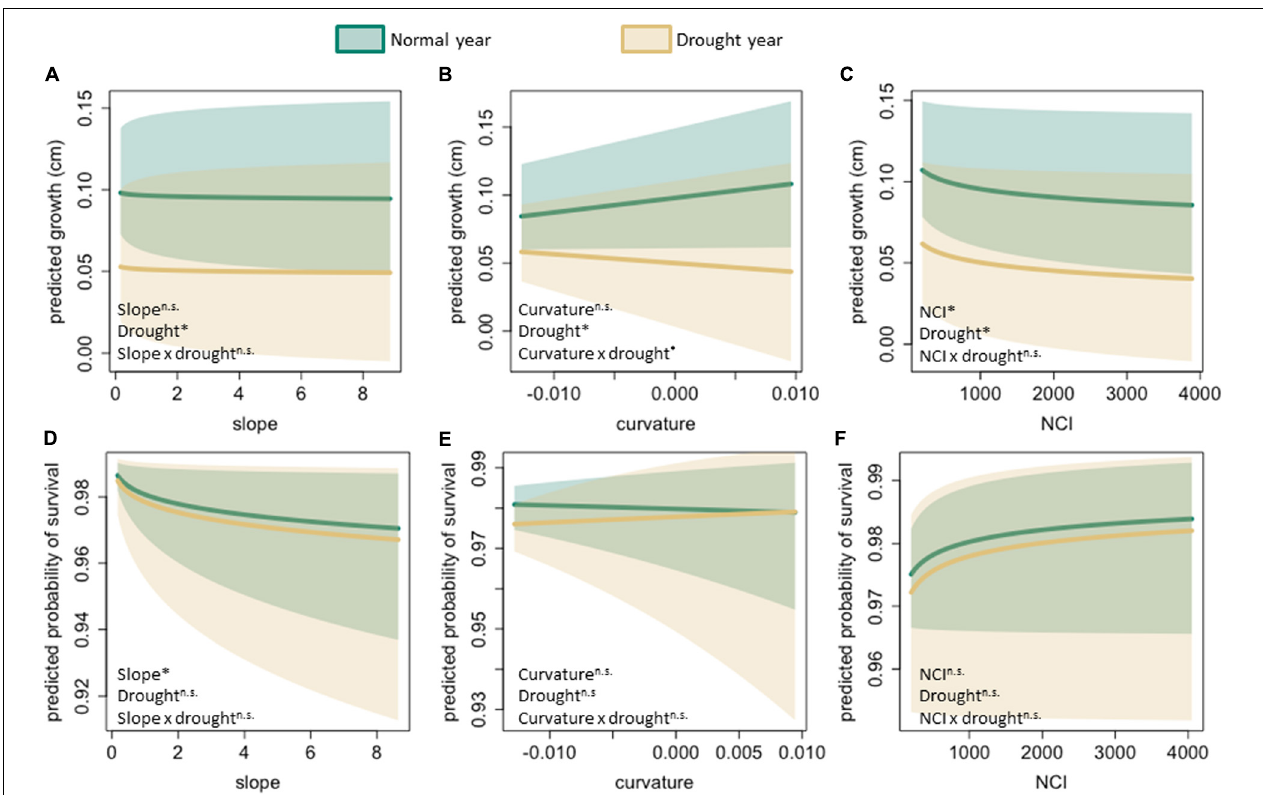
FIGURE 3 | Predicted growth (A–C) and probability of survival (D–F) as a function of slope, curvature, and neighborhood crowding. Green lines and shaded areas show the fitted values for the relationship between each predictor and response variables (and their 95% credible intervals) at average rainfall during the non-drought years (i.e., 2014, 2016 average). Brown lines and shaded areas show relationships during the drought year. Text in the lower left corner indicates whether main effects and interactions were significant ( ∗ P < 0 . 05), marginally significant (ˆ p < 0 . 1), or not significant